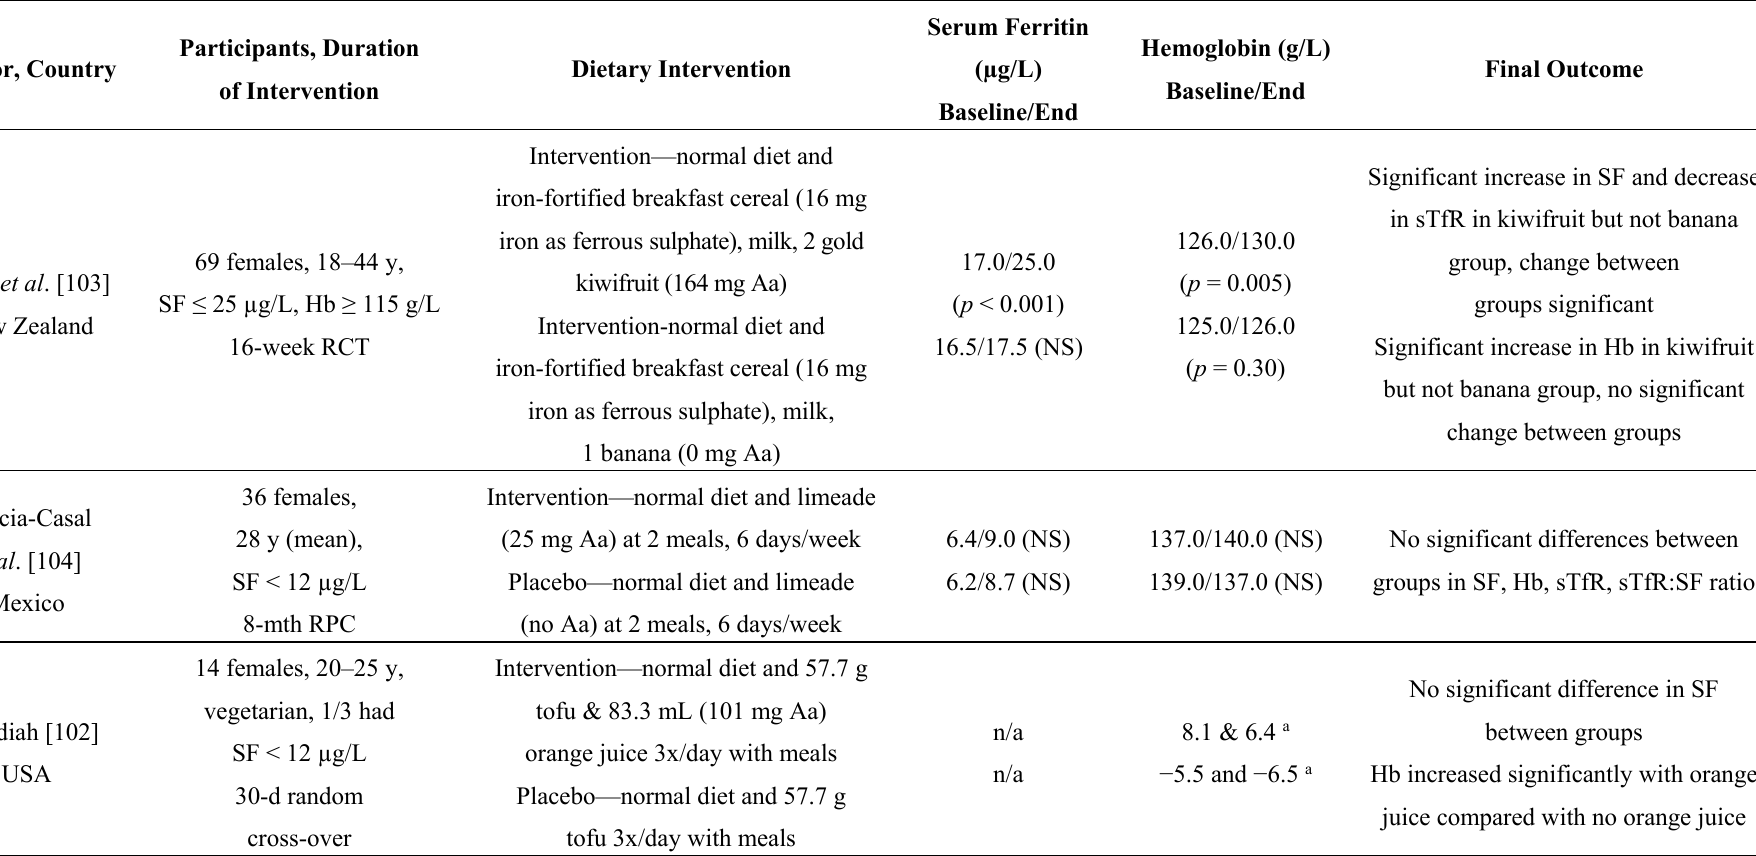
Table adapted from “Iron and Health” Scientific Advisory Committee on Nutrition [20]; a : Change in Hb concentrations during first and second experimental period. Abbreviations: Aa—Ascorbic acid; Hb—Hemoglobin; n/a—not available; NS—non significant; RCT—Randomized controlled trial; RPC—Randomized placebo controlled; SF—Serum ferritin; sTfR— Soluble transferrin